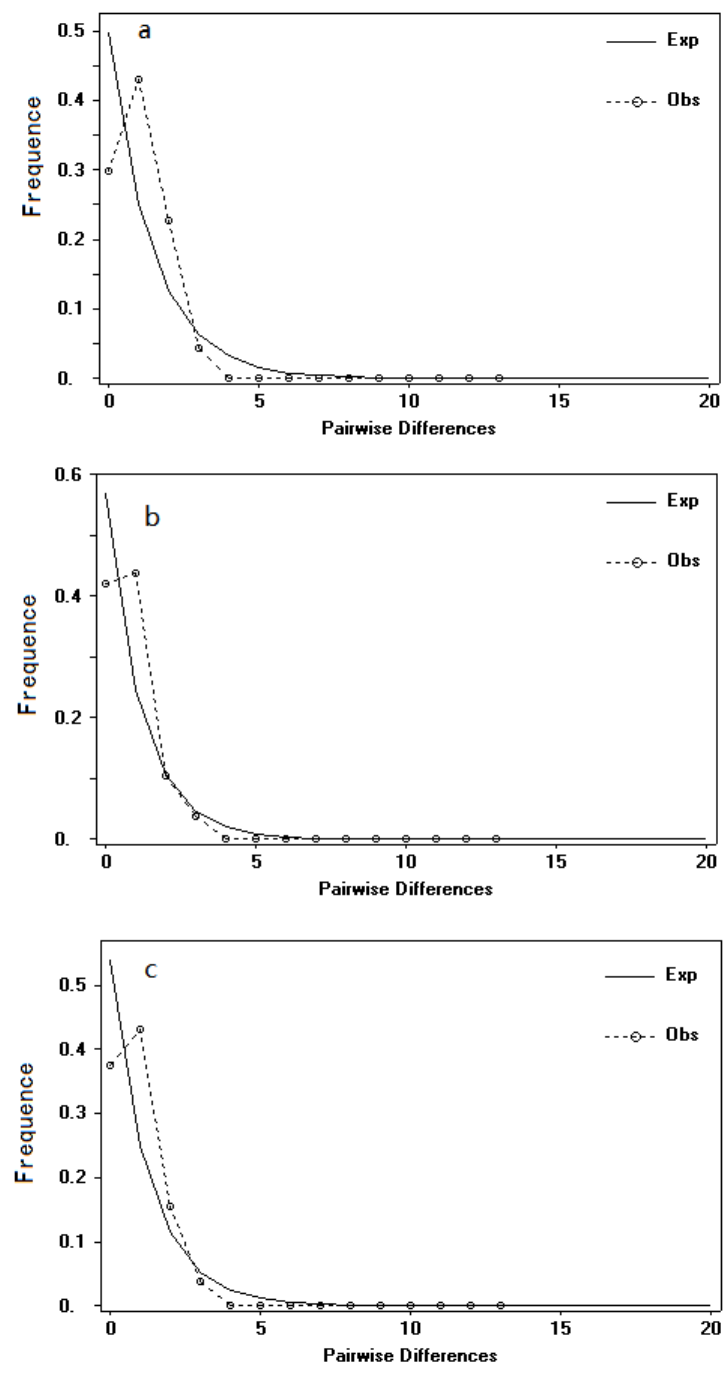
Figure 4. Mismatch distributions for the blue shark populations sampled in the Pacific Ocean: ( a ) mismatch distribution for the Northern Hemisphere stock; ( b ) mismatch distribution for the Southern Hemisphere stock; and ( c ) mismatch distribution for all samples. We count the number of site differences between each pair of sequences in a sample, and use the resulting counts to build the histogram.